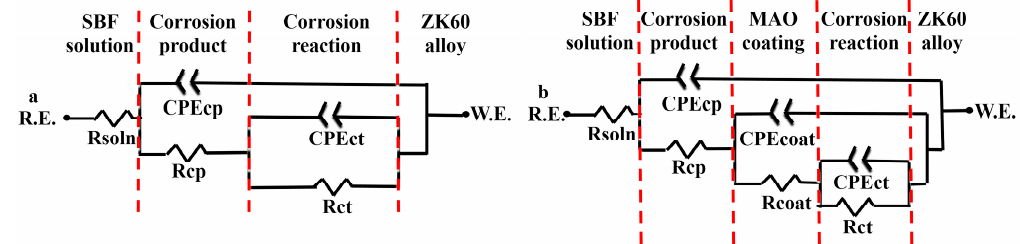
Figure 10. Equivalent circuits for fitting the impedance data of ( a ) the uncoated and ( b ) the MAO coated samples in SBF. CPE: constant phase